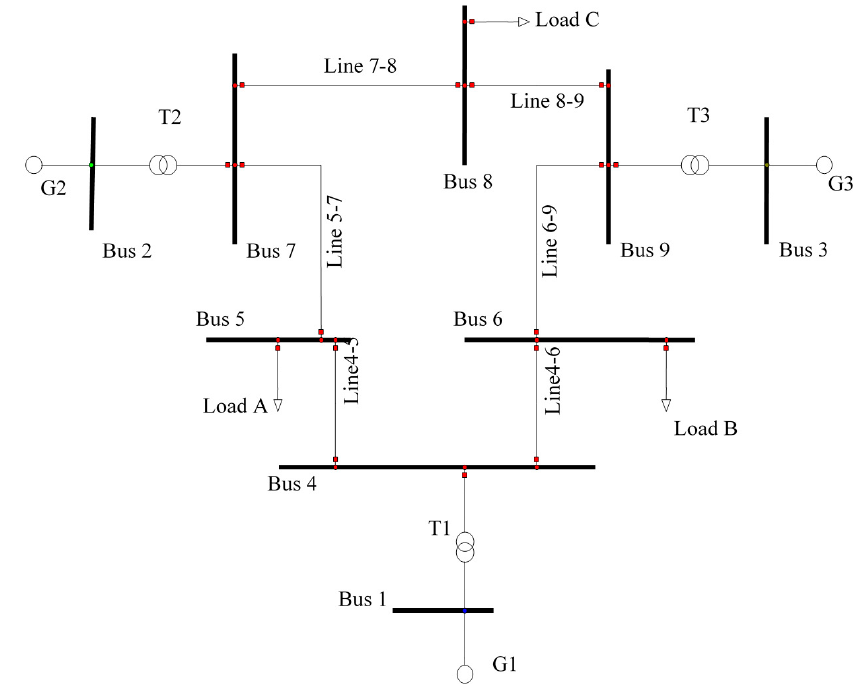
Figure 1. Power system under study with 9-bus [37]. Reproduced with permission from publishing company, 2014.